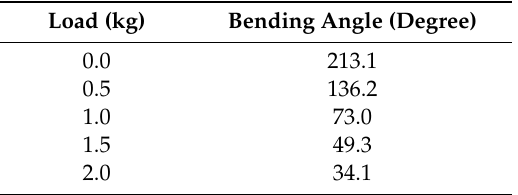
Figure 2. The structure of the self-bending contraction actuator version I. ( a ) The layout of the reinforcement rod. ( b ) The bending actuator after several operations. Table 1. The maximum bending angle at di ff erent loads for 30 cm